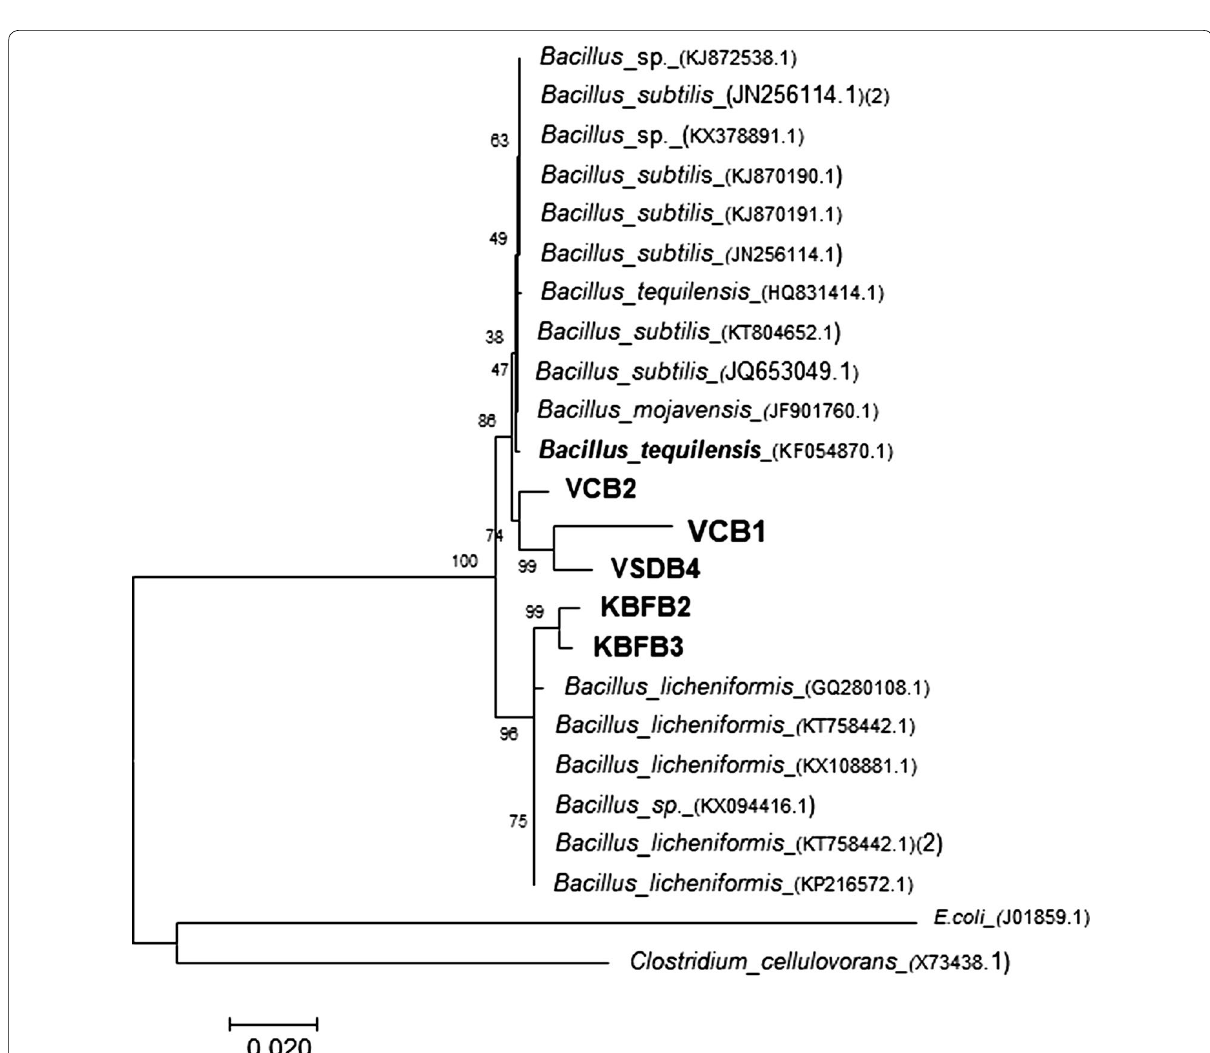
Fig. 3 Phylogenetic dendogram based on the 16S rDNA sequences of isolates and reference sequences retrieved from genbank. The phylogenetic tree was constructed based on neighbourhood joining method (NJ) using Mega 7.0 software with a bootstrap value of